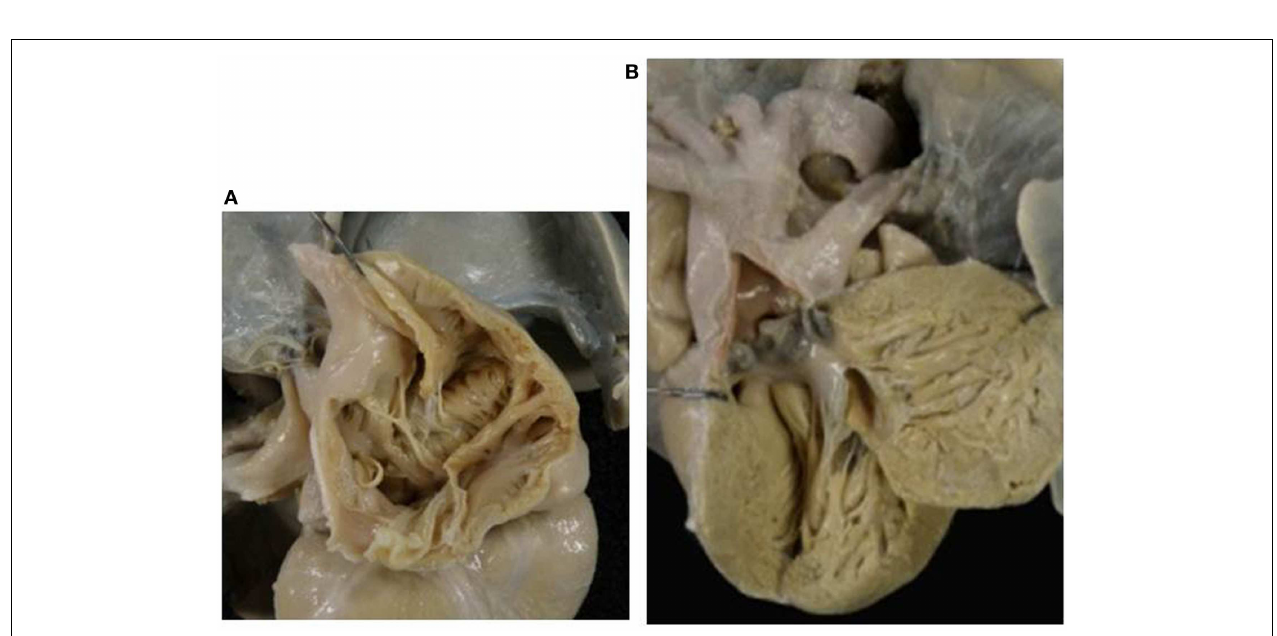
FIGURE 9 |Absent rightAV connection (tricuspid atresia) with concordantVA connection . (A) There is no connection between the right atrium and the underlying right ventricle.The diminutive right ventricle is located interiorly and on the right ( D -loop) lacks of an inlet portion and gives origin to a hypoplastic pulmonary artery.The two ventricles communicate through a ventricular septal defect. (B) The left atrium drains through a mitral valve into the left ventricle.